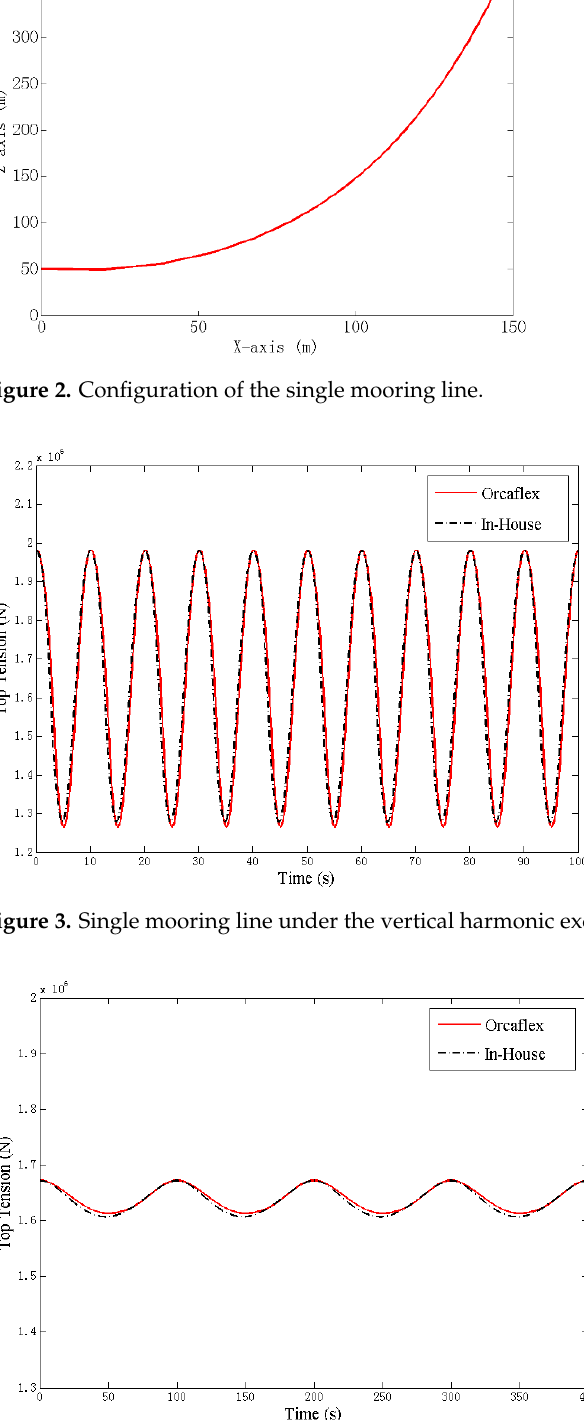
Figure 5. Single mooring line under the combined vertical and horizontal harmonic excitations. 3.2. Single-Component Mooring Line under Harmonic Excitation with Wave and Current In this case, the environmental loads from wave and current were applied to the lines. The wave is an airy wave that has a wave height of 7.0 m and a period of 8.0 s. The current is 1 m/s in the x-direction and linear decay, along with the depth until zero at the seabed. Additionally, the mooring line was still subjected to three harmonic excitations, i.e., ver- tical, horizontal, and combined vertical and horizontal harmonic excitations. Both the re- sults of mooring line dynamic analysis by the in-house code and Orcaflex are shown in Figures 6–8. It can be seen that the agreement is well, and the difference is within 1%.